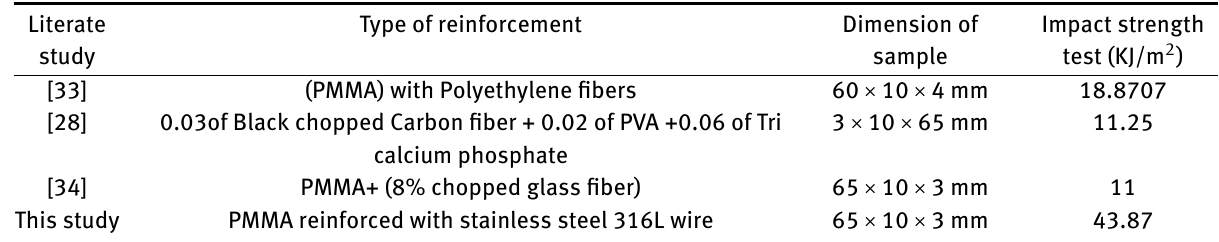
Table 3: Comparison of the results of the previous study with the result of this study Literate